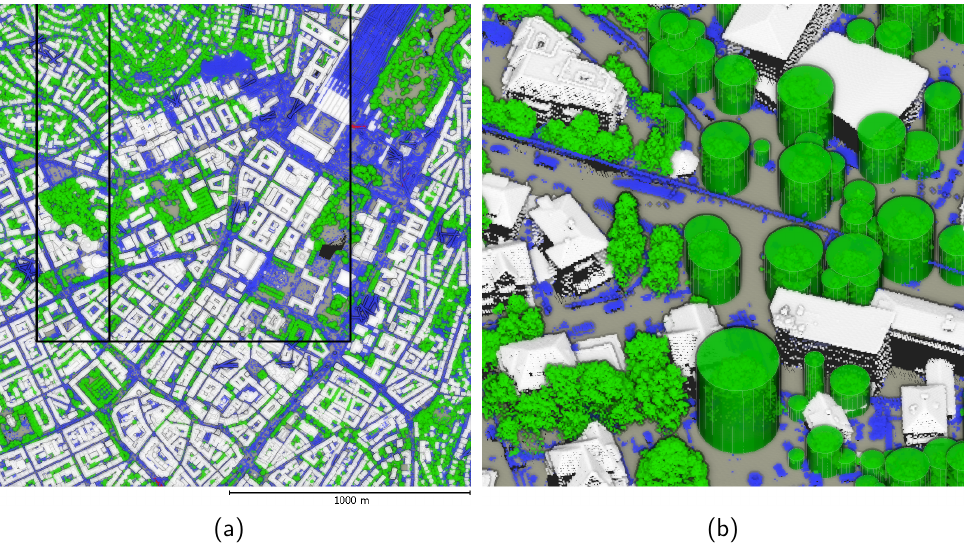
Figure 2. Ground truth of the dataset. ( a ) Overview with the three subsets visually delineated: training split in the center, the slim validation split and the u-shaped test set. ( b ) Detailed view with ground truth cylinders on the right side. Grey: ground ; white: building ; green: tree ; blue: other . Weak labels for pre-training were generated from an 12 km 2 space around the core study area via Baseline A (see Section 3.3). There were 10 of the 1 × 1 km tiles (30,101 trees) used for training and 2 tiles (7028 trees) for